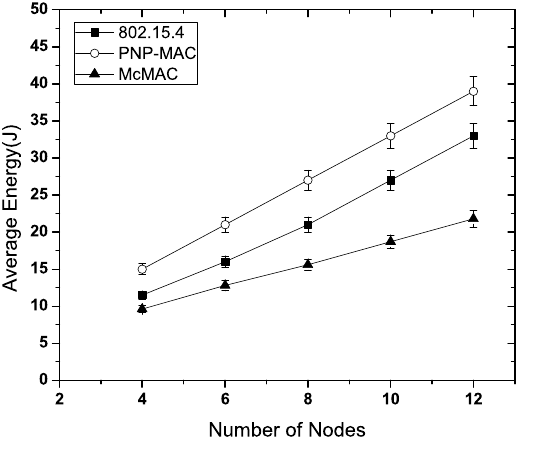
Figure 11. Average energy consumption at varying number of nodes.